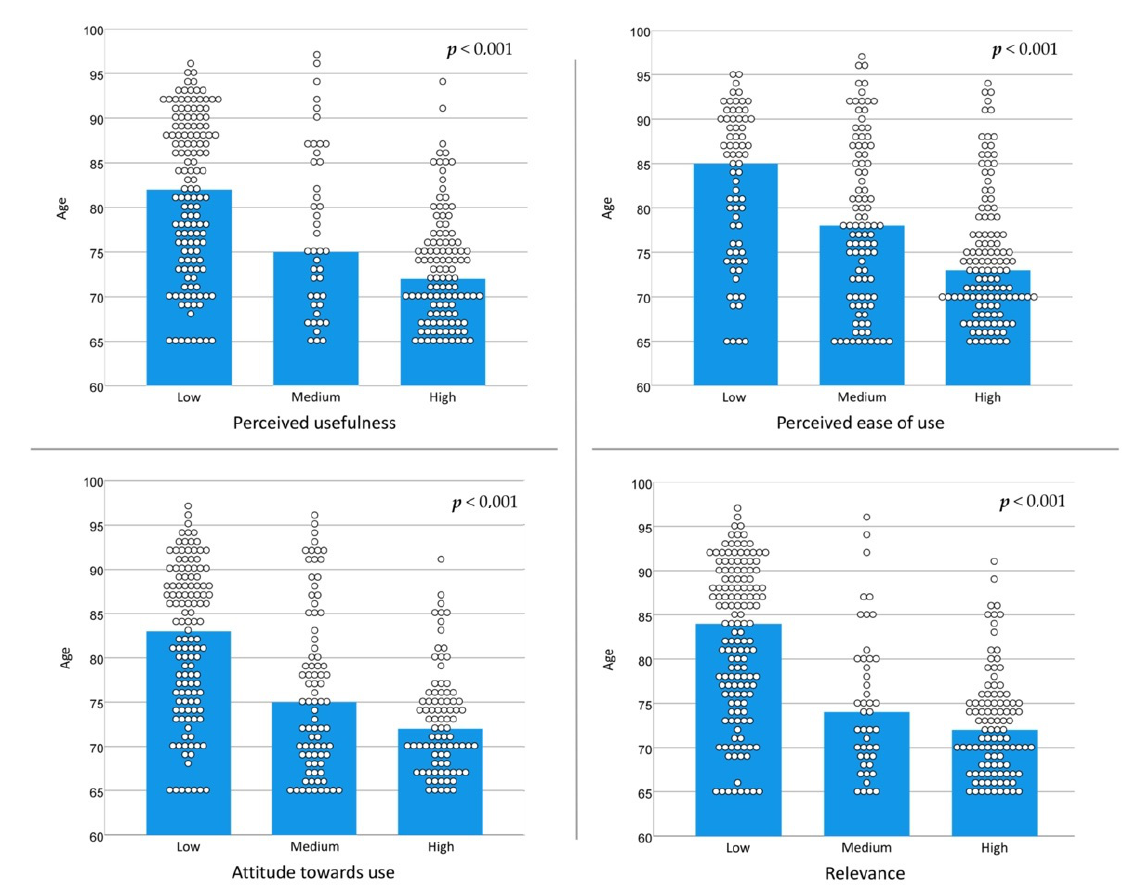
Figure 1. Age (median) and the degree of acceptance of new technologies in the dimensions of the TAM. TAM score: low, 0 to 18.3; medium, 18.4 to 36.6; high, 36.7 to